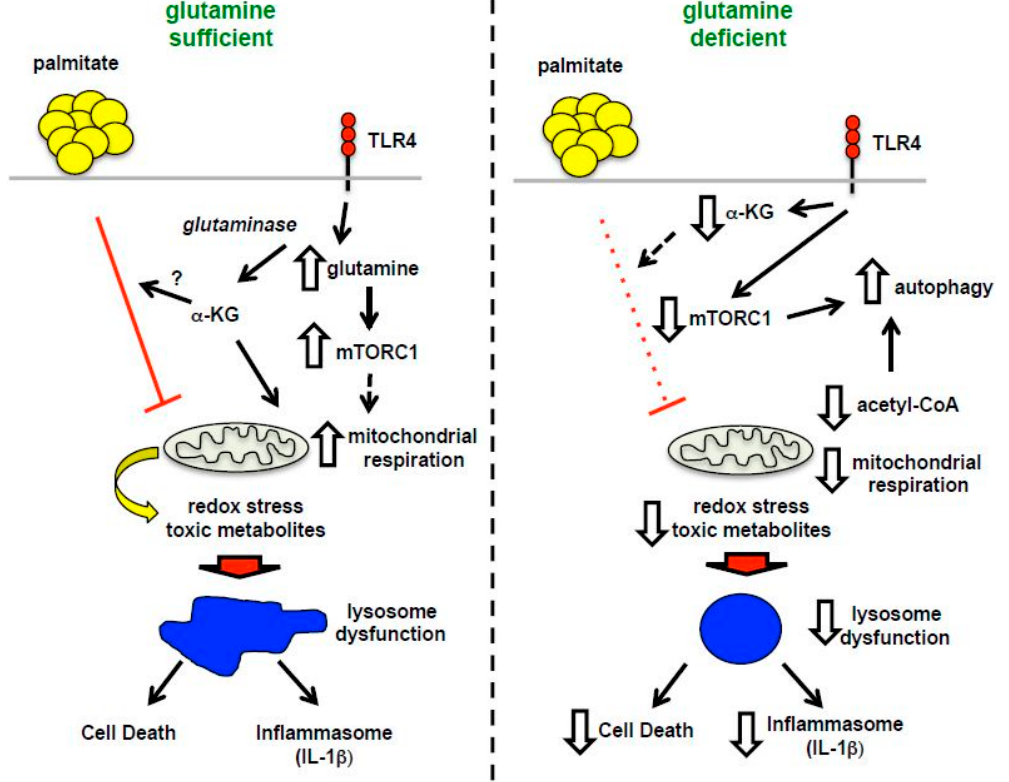
Figure 10. Model of macrophage lipotoxicity under glutamine sufficient and deficient conditions. When glutamine is available, TLR4 activation stimulates glutamine uptake, mTORC1 activation, enhanced formation of TCA intermediates, such as α -KG, and increased mitochondrial respiration. The presence of excess fatty acids like palmitate leads to suppression of mitochondrial respiration, which in the setting of LPS activation likely promotes accumulation of toxic metabolites, lipids and/or redox stress. Lysosome dysfunction ensues leading to macrophage cell death and inflammasome activation. In the absence of glutamine, mTORC1 activation and mitochondrial respiration are diminished leading to enhanced rates of autophagy. In this scenario palmitate no longer suppresses mitochondrial function, which appears to protect against lysosome dysfunction, perhaps by decreasing the formation of damaging metabolites and